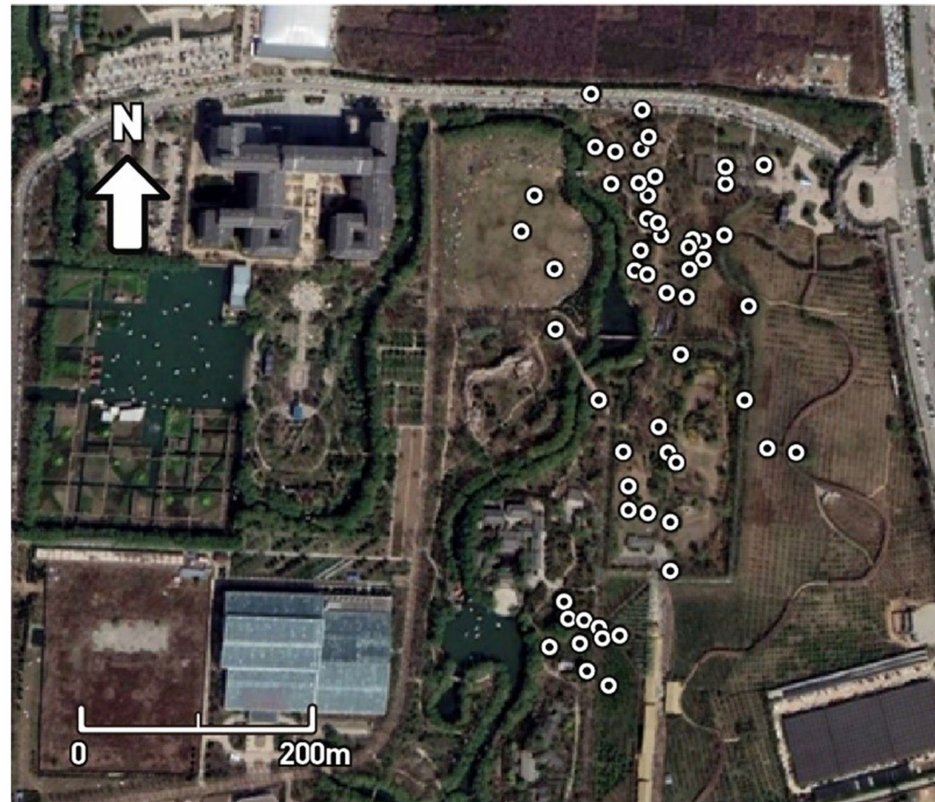
Figure 2. Sketch map of observation points and surrounding trees.